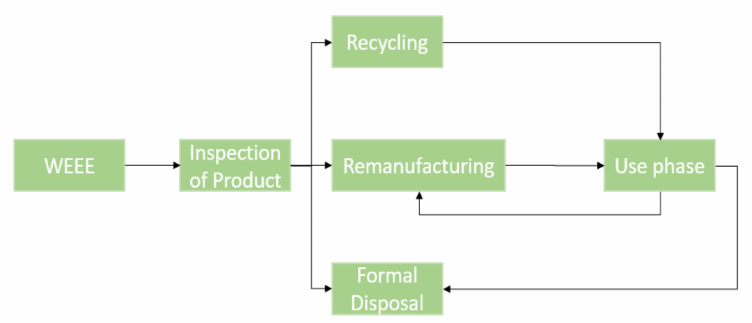
Figure 2. Different methods of electronic waste